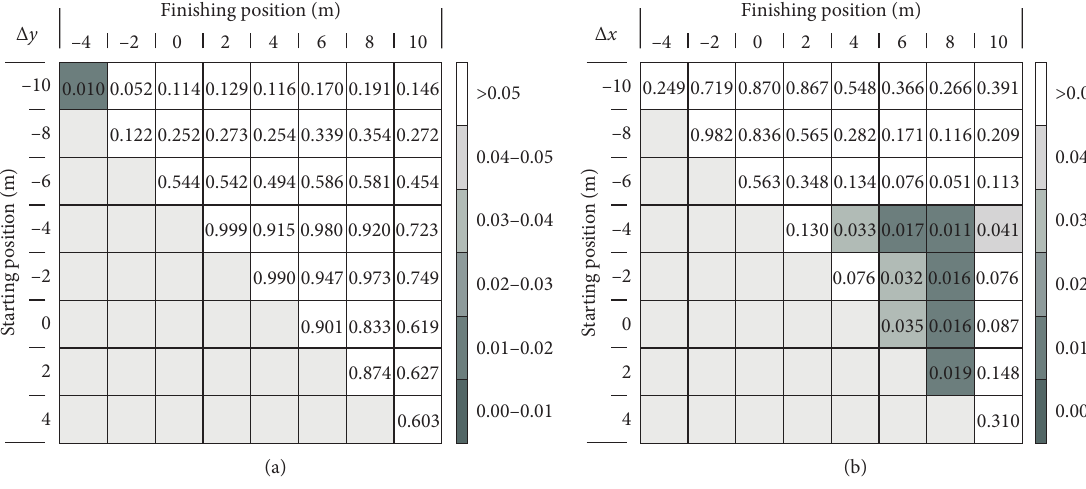
Figure 8: The p value of entrance density with lateral and longitudinal deviations.